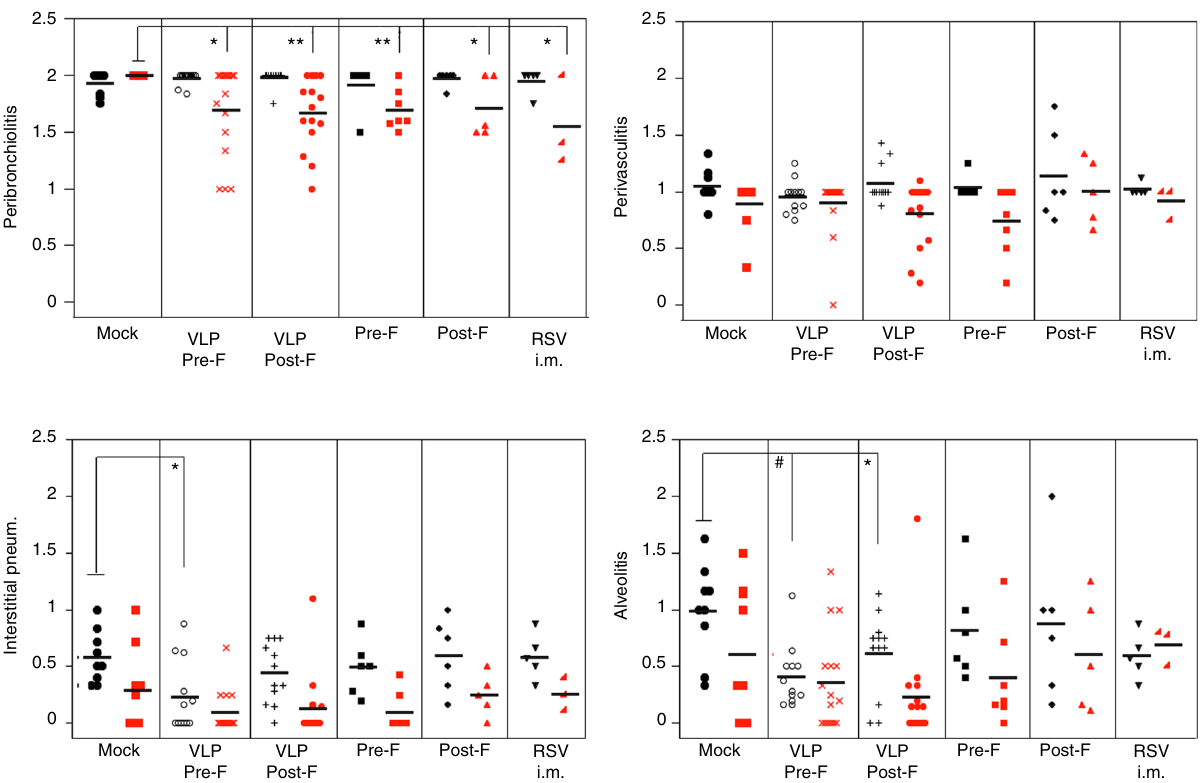
Fig. 6 Lung pathology in offspring. Lung histopathology scores in RSV-infected litters born to unprimed (black symbols) or RSV-primed (red symbols) dams that were vaccinated once during pregnancy as indicated. Each symbol represents the mean of each litter. Lines across represent mean. Comparison of the histopathology between the respective mock-vaccinated, the test-vaccinated, or RSV i.m.-vaccinated groups was assessed by non-parametric Kruskal – Wallis test. * p < 0.05; # p <